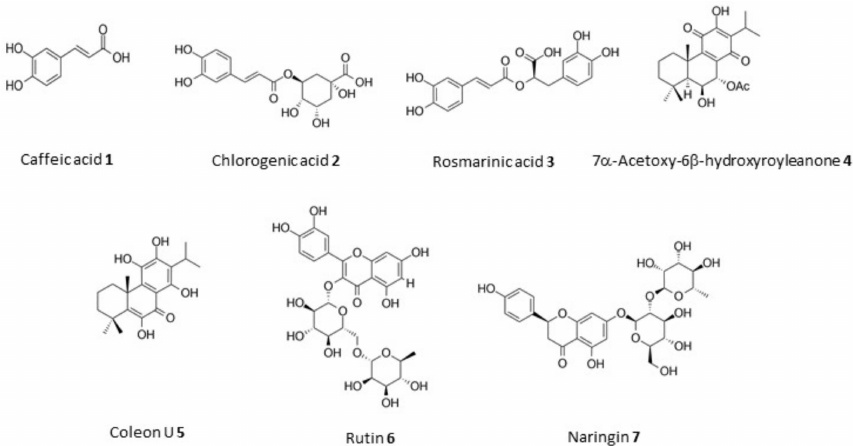
Figure 1. Structures of ca ff eic 1 , chlorogenic 2 and rosmarinic 3 acids, abietane diterpenes (7 α -acetoxy- 6 β -hydroxyroyleanone 4 and coleon U 5 ) and flavone glycosides (rutin 6 and naringin 7